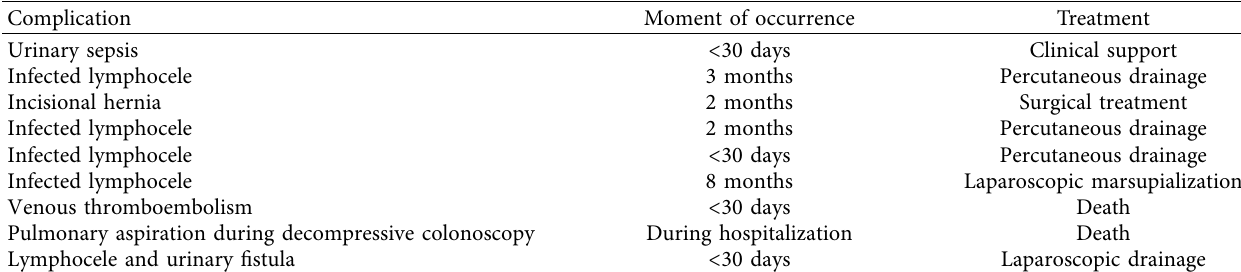
Table 5: Severe postoperative complications (Clavien 3–5), a moment of occurrence and treatment performed ( n �